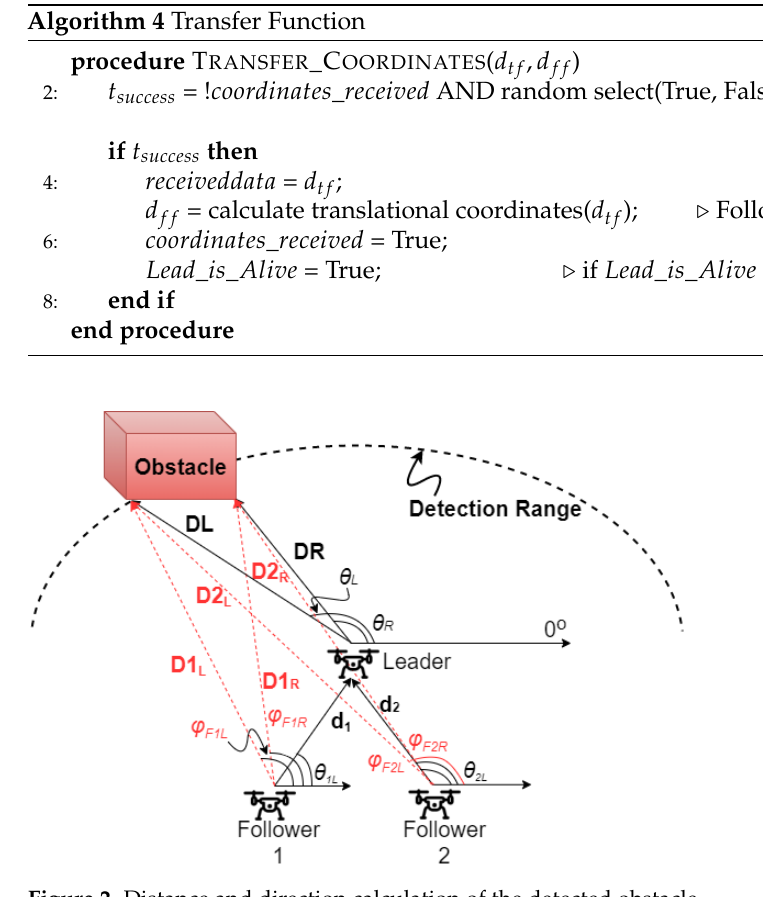
Figure 2. Distance and direction calculation of the detected obstacle. Table 1. Description of Variables from Figure